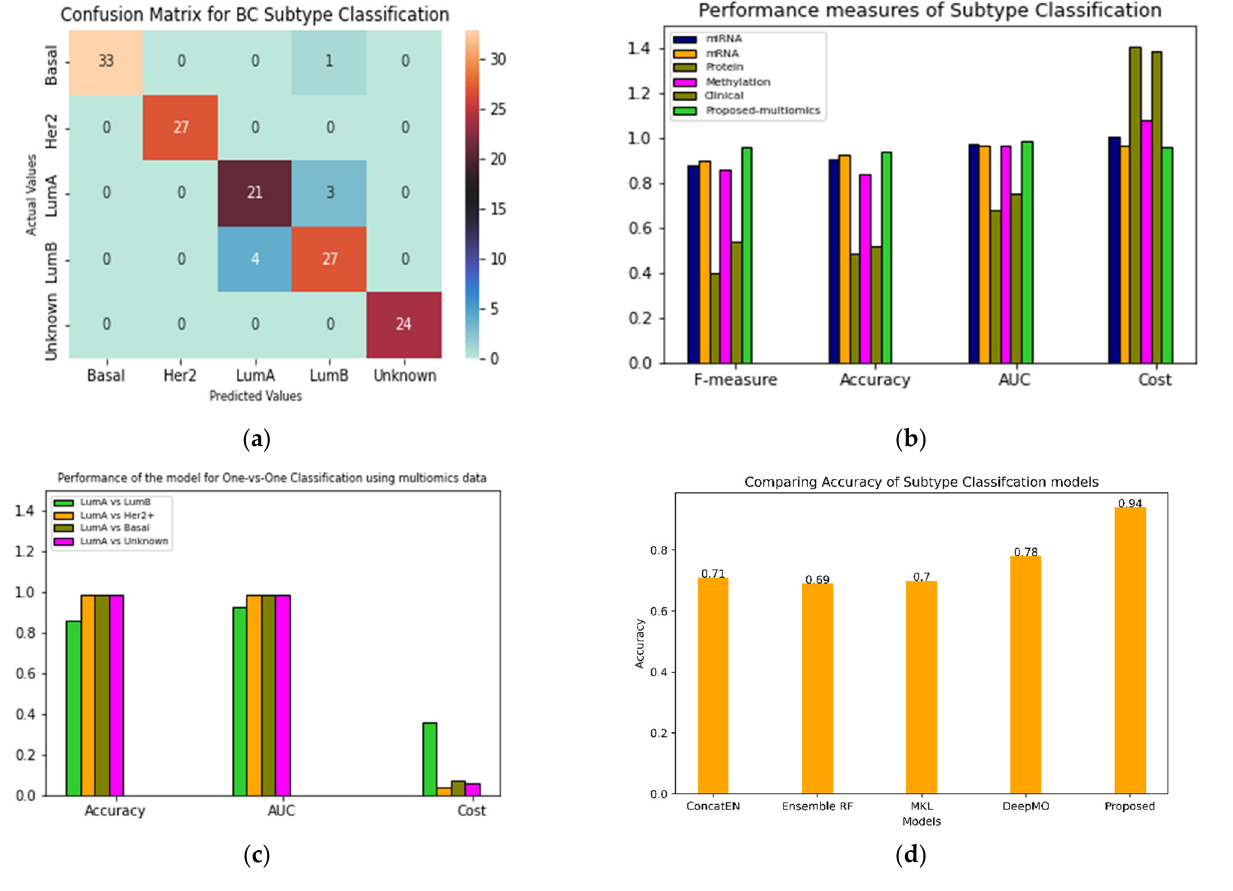
Figure 2. BC Subtype classification performance. ( a ) Confusion matrix for 140 test samples. ( b ) Single vs. multi-omics data performance comparison ( c ) Binary classification with Luminal A as common subtype in each case. ( d ) Comparison of existing methods; concatenated elastic net and random forest are in-house methods. DeepMO and MKL are mentioned in the